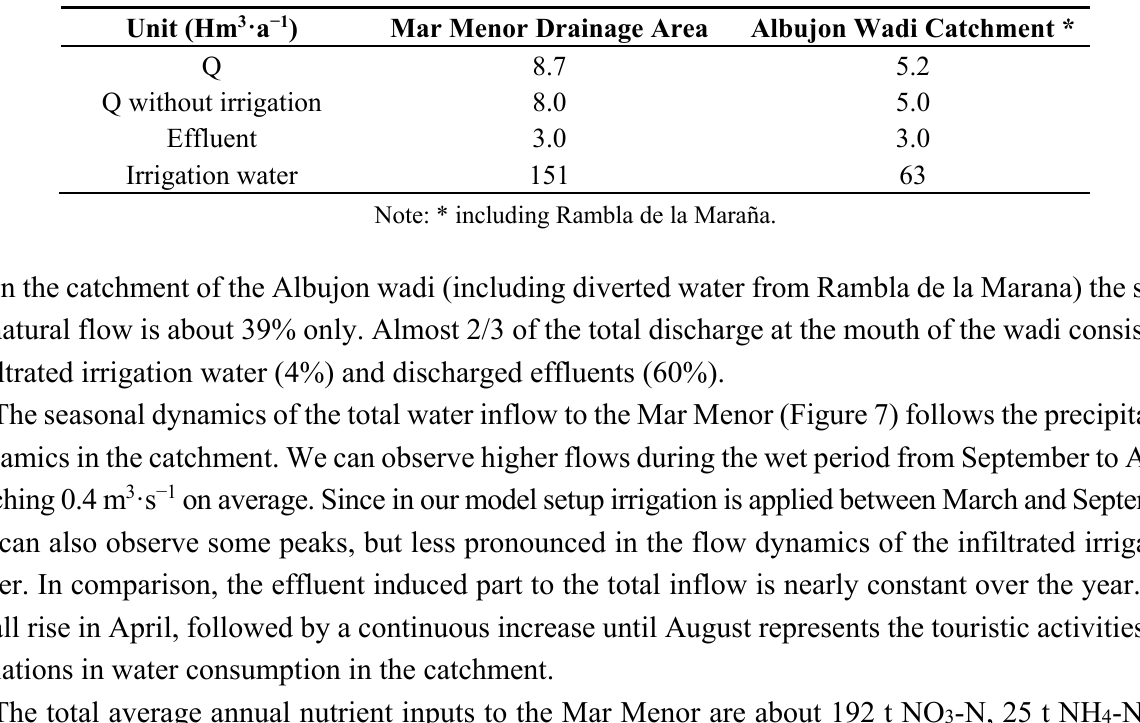
Table 4. Values of long-term average annual (2002–2011) simulated water inflow from the total drainage area of the Mar Menor and from the catchment of the Albujon wadi to the lagoon, as well as of the amount of additional water added to the whole system (effluent and irrigation